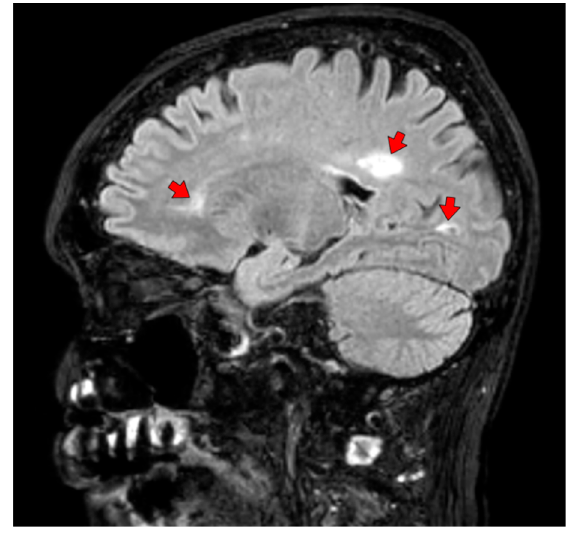
Figure 1. A fluid attenuation inversion recovery (FLAIR) image from a patient with sarcoidosis showing silent white matter hyperintensities.